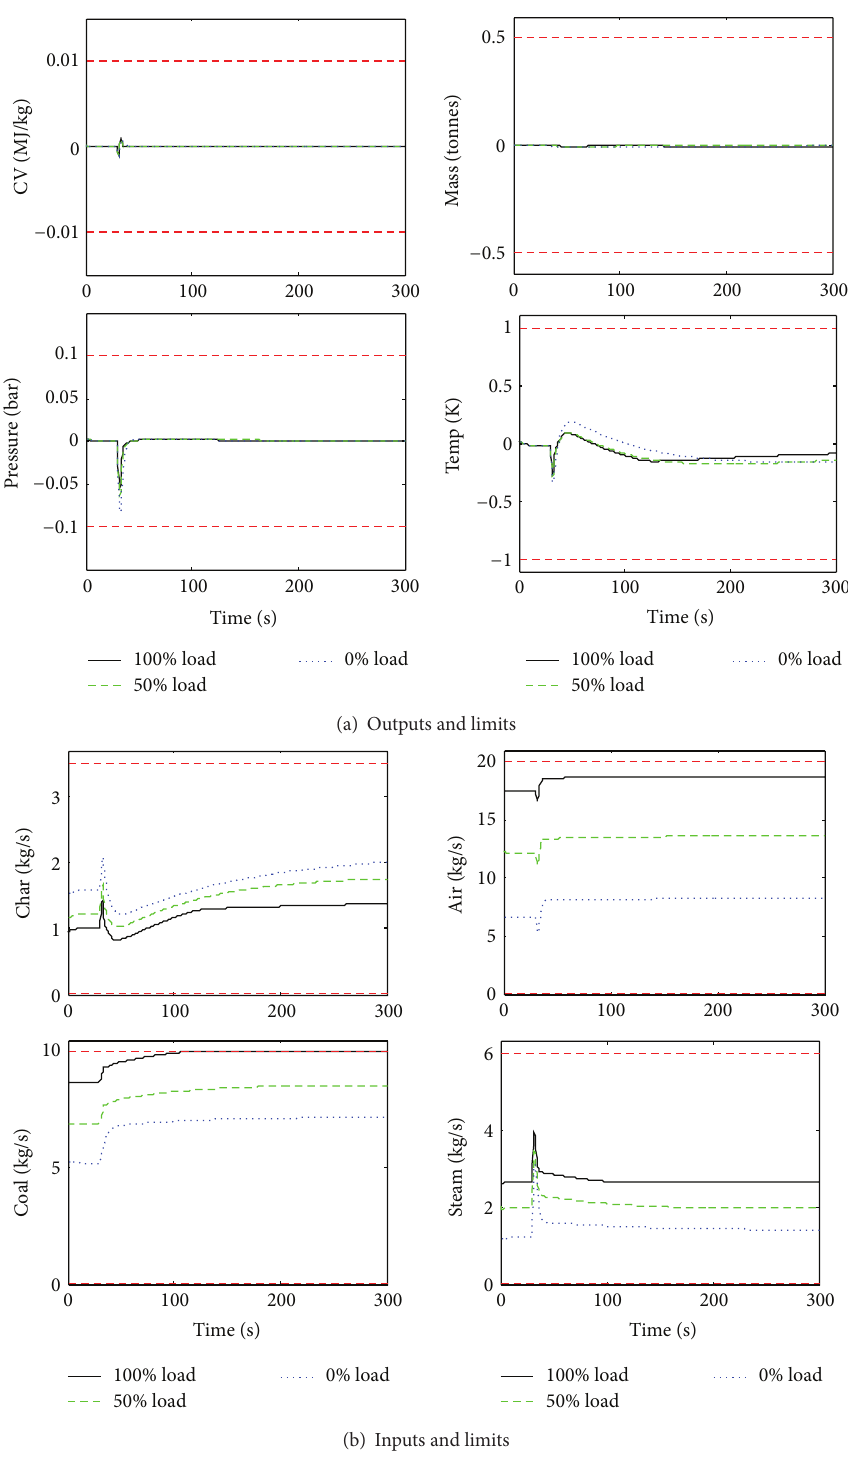
Figure 3: Response to step disturbance at 0%, 50%, and 100%